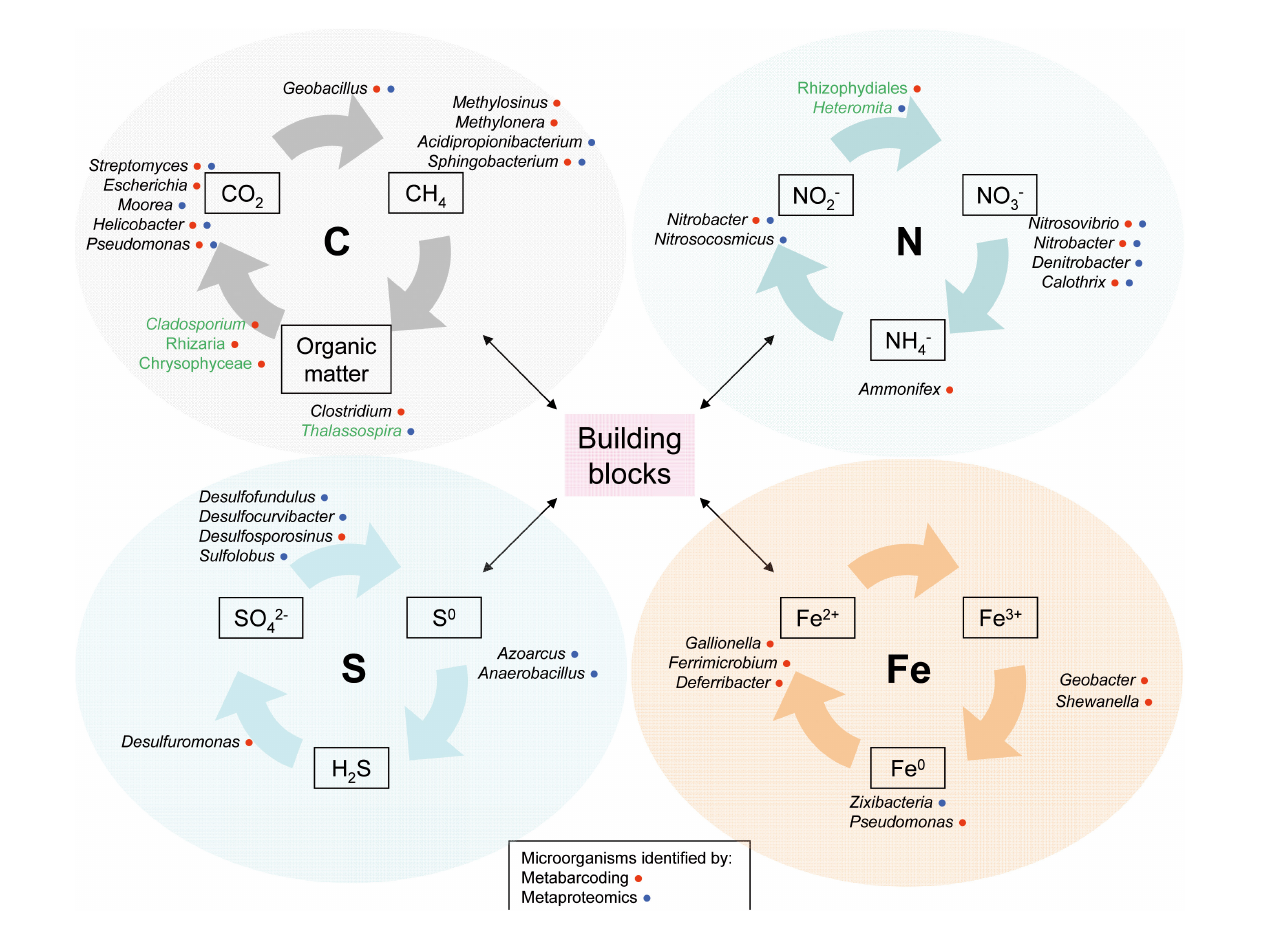
FIGURE6 Model of the metabolic potentials between dominant microorganisms in the ice cave. Some key members were represented at genus level (Prokaryotes in black, Eukaryotes in